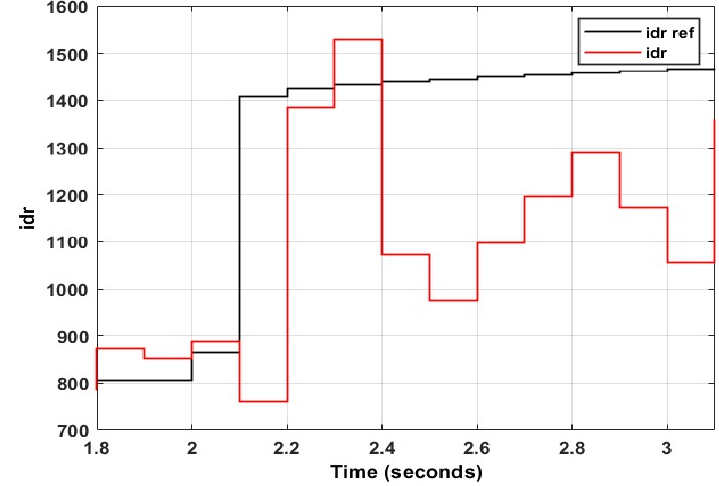
Figure 40. Rotor direct axis current average using DCI at 80% dip.